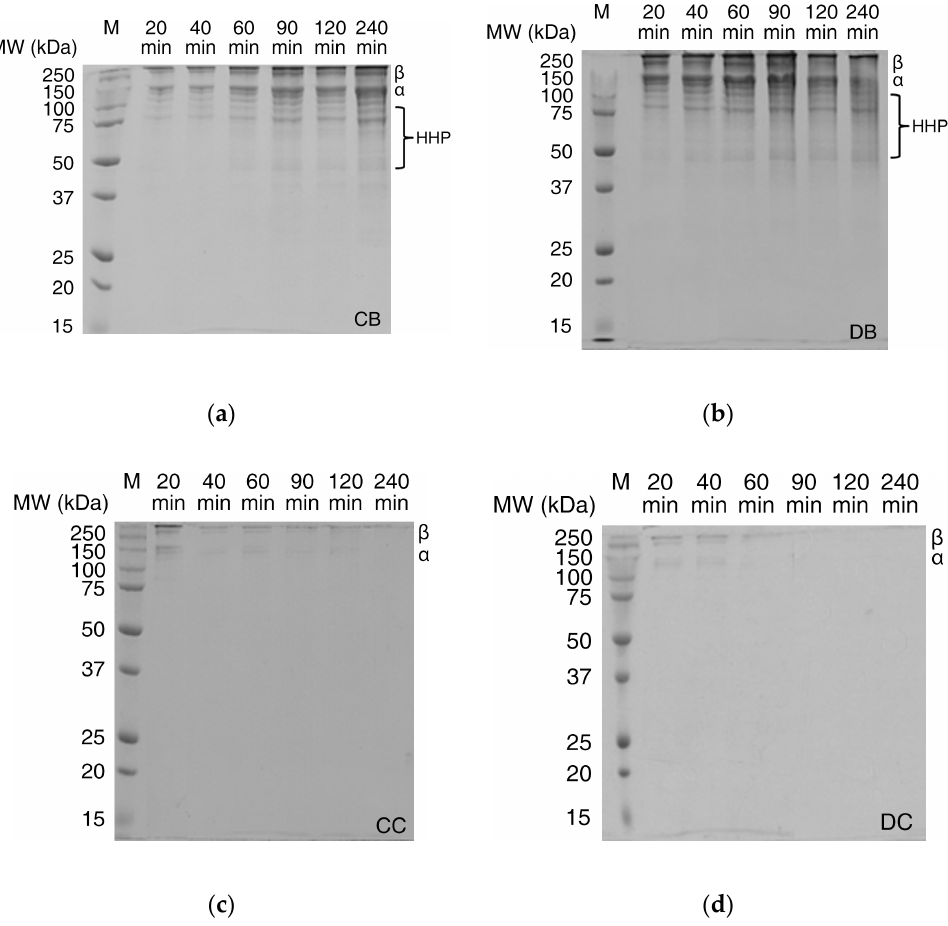
Figure 3. SDS–PAGE of supernatants using 12% acrylamide gel of ( a ) C-coll hydrogel in Tris buffer, pH 7.4 (CB); ( b ) D-coll hydrogel in Tris buffer, pH 7.4 (DB); ( c ) C-coll hydrogel in collagenase solution in Tris buffer, pH 7.4 (CC) and ( d ) D-coll hydrogel in collagenase solution in Tris buffer, pH 7.4 (DC). The lane of protein marker is labelled as M and shows the corresponding molecular weights. The collagen bands of α chains, β chains and high molecular weight hydrolyzed peptides (HHP).